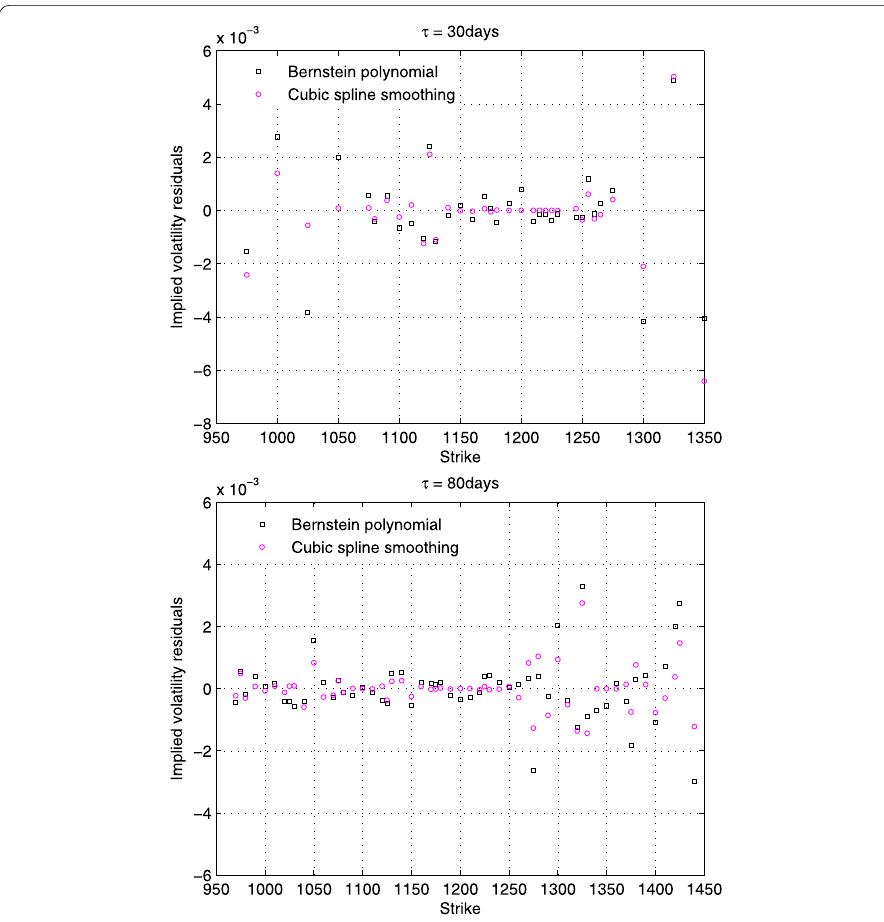
Figure 5 Implied volatility residuals computed as σ i – ˆ σ i , where ˆ σ i denotes the values of estimated implied volatility. Results are reported for both of the times to maturity of τ = 30 days and τ = 80 days,